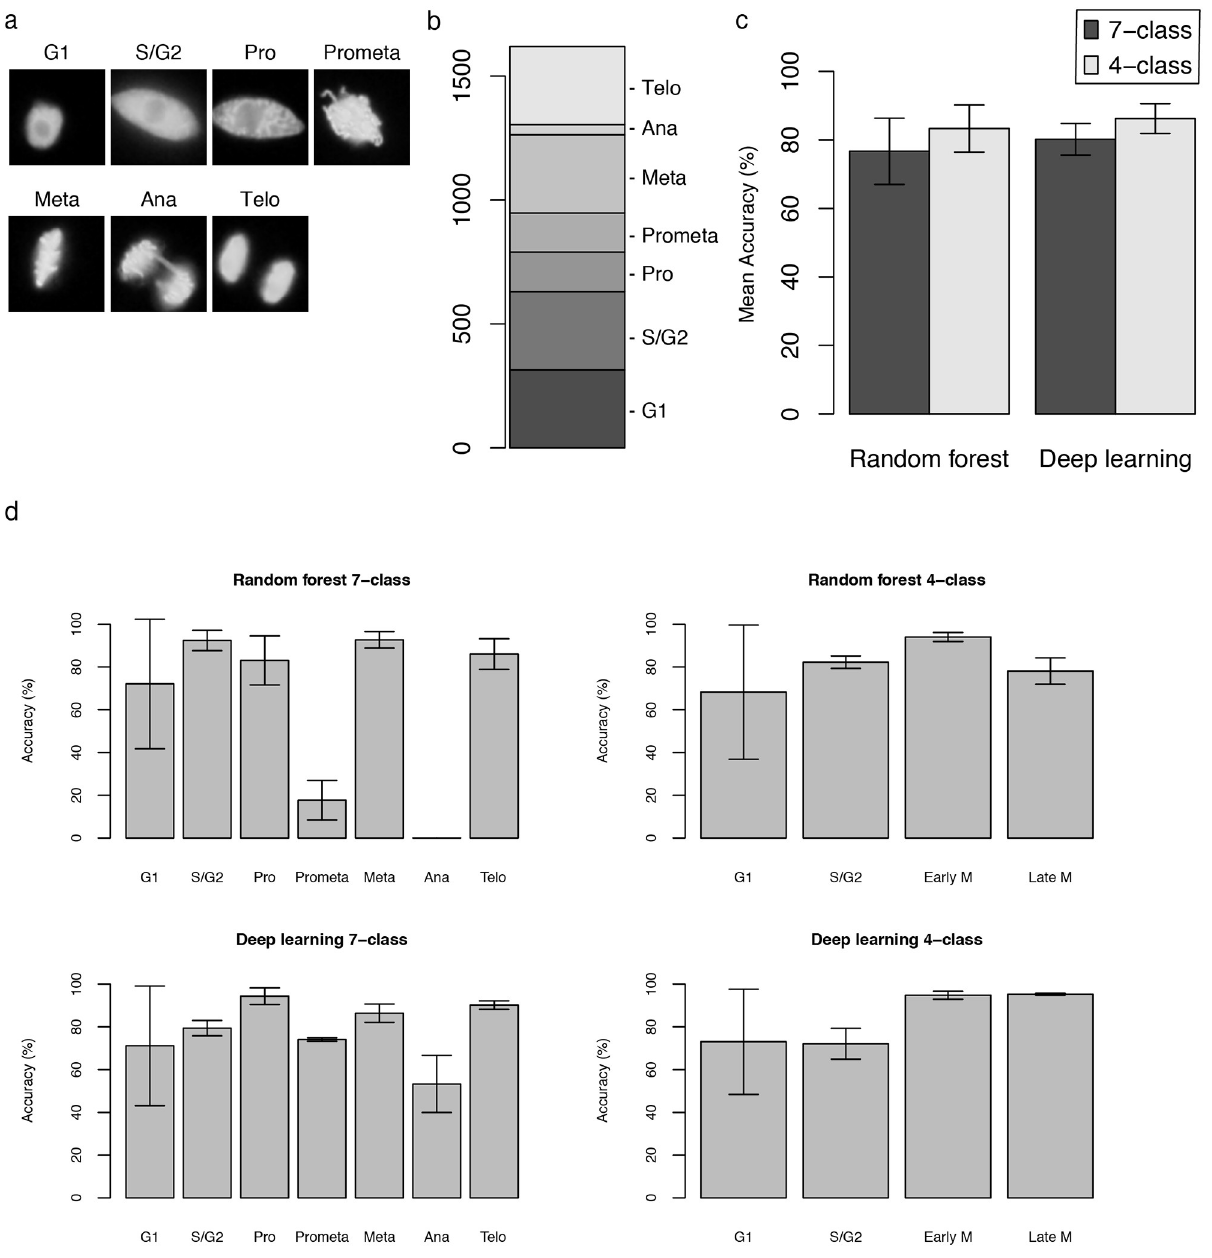
Fig 3. Results of the IMACEL classifier for cell cycle classification with nucleuses visualised using fluorescent images. (a) Representative images of each cell cycle in suspension-cultured plant cells. Nuclear regions were visualised using RFP-Histone H2B. (b) Distribution of the number of dataset images in each class. (c) Mean accuracy of cell cycle classification in seven-class and four-class classification using random forests and deep learning. For four-class classification, the prophase, prometaphase, and metaphase were integrated into the early mitotic phase. Anaphase and telophase were integrated into the late mitotic phase. (d) Accuracy of each cell cycle classification with bars representing the standard deviation based on three independent experiments.